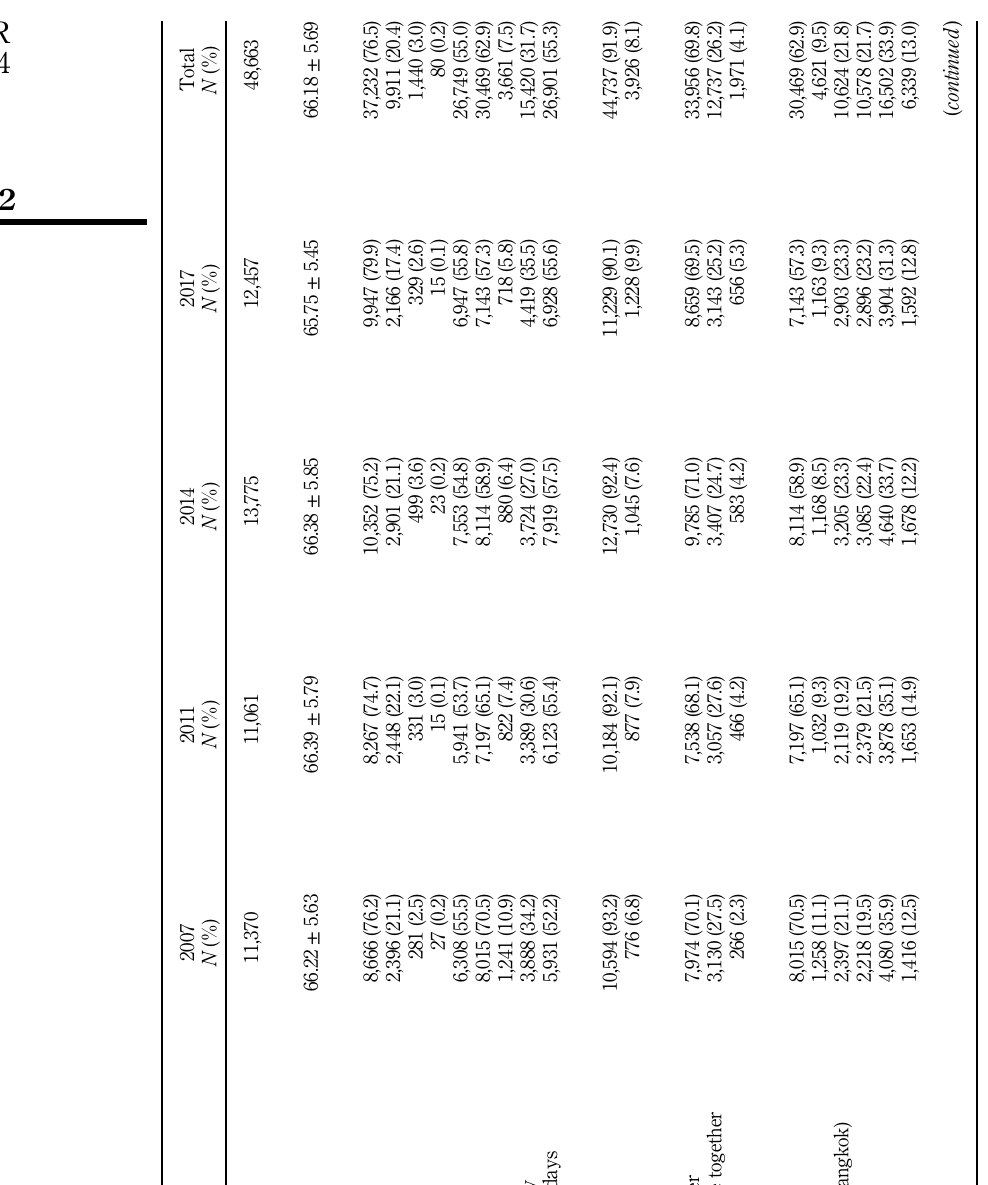
Table 2. Characteristics of the study population by year, weighted by probability